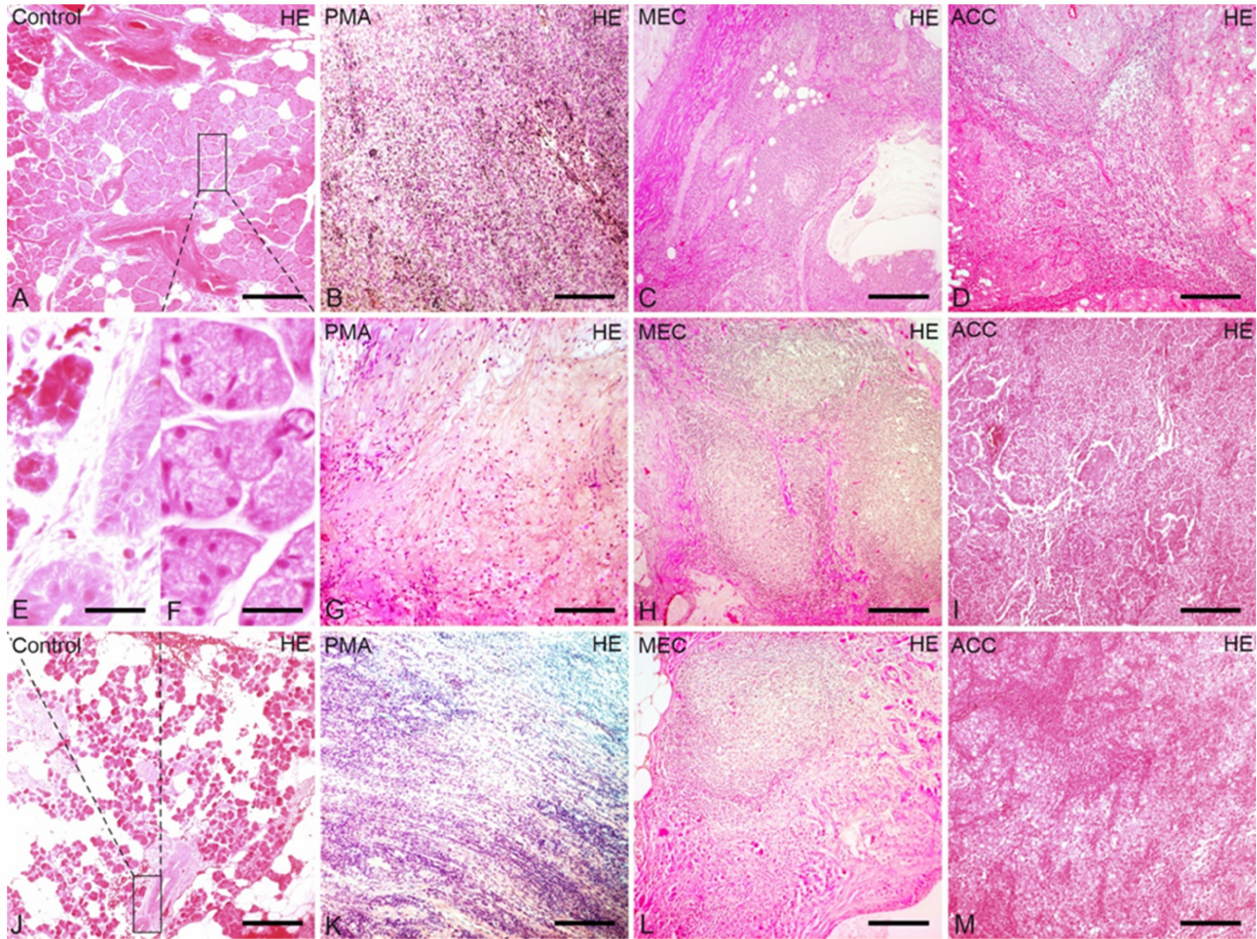
Figure 1. Comparison of the structural differences between control, PMA, MEC and ACC parotid gland tissue using HE staining: Control parotid gland 1 in HE staining ( A ) and the magnification of its acinic cells in HE staining ( F ). Control parotid gland 2 in HE staining ( J ) and the magnification of its striated duct cells in HE staining ( E ). In comparison, MEC ( C , H , L ) consists mostly of squamous and mucus-forming epithelium and ACC ( D , I , M ) consists of uniform acinar cells. In contrast, PMA ( B , G , K ) consists of epithelial and mesenchymal lineage differentiations. Bars represent 175 µ m: ( A – D , G – M ); 32, 5 µ m: ( E , F